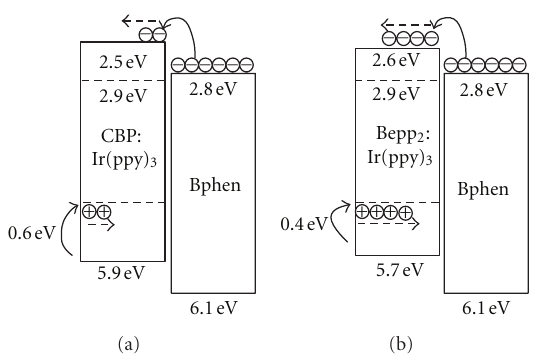
Figure 5: Energy level diagrams of CBP:Ir(ppy) 3 (a) and Bepp 2 :Ir(ppy) 3 PHOLEDs (b).